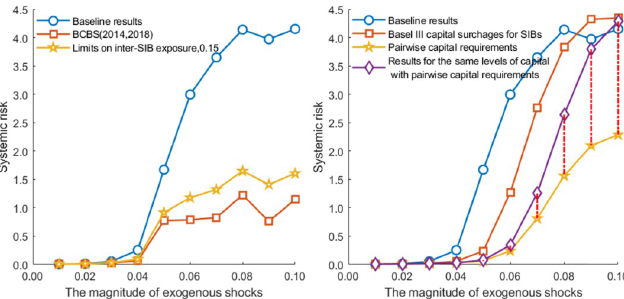
Fig 18. The results of the proposed policies for changing the magnitude of exogenous